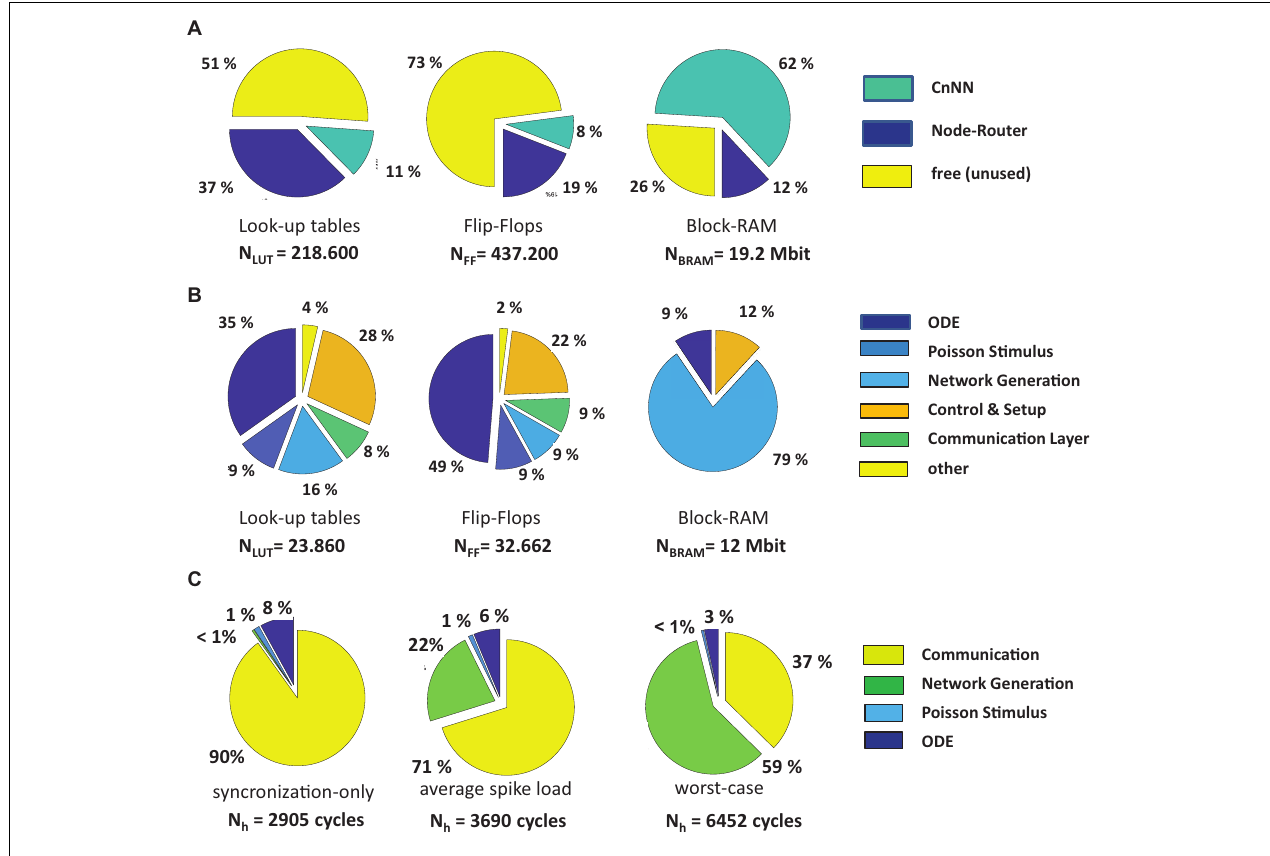
FIGURE 8 | Overall resource breakdown including the node router logic (A) , resource breakdown of the CsNN architecture, without node router logic (B) , breakdown of the time step latency (C) .